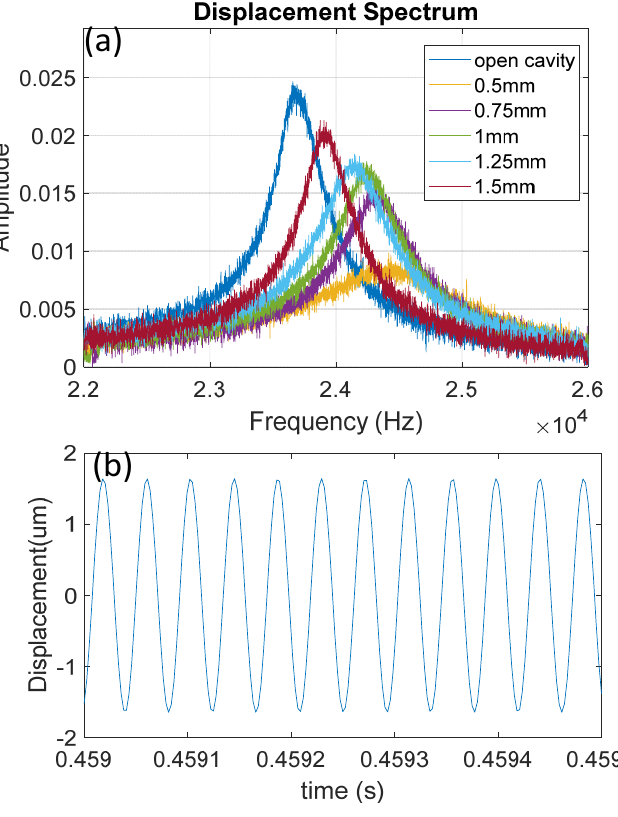
Figure 7. Experimental results of ( a ) displacement frequency spectrum for the varied cavity lengths of the PMUT; ( b ) measured displacement of the device at the open-cavity condition.